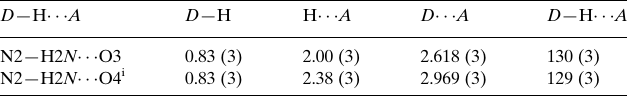
Hydrogen-bond geometry (A˚ , (cid:3)